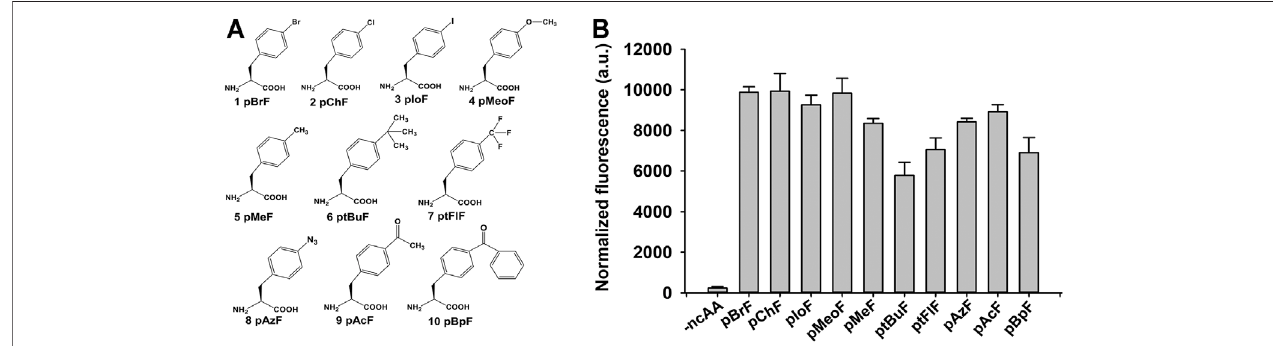
FIGURE 4 | Structures and suppression ef fi ciencies of non-canonical amino acids (ncAAs). (A) Structures of 10 ncAAs used in this study. (B) Incorporation ef fi cienciesofdifferentncAAswereevaluatedusing GreenFluorescenceProtein(GFP)-basedassay.In-cell fl uorescenceofGFPvariant Tyr151TAG wasrecordedusing plate reader. Values are means ± Standard Deviation (SD) of three independent